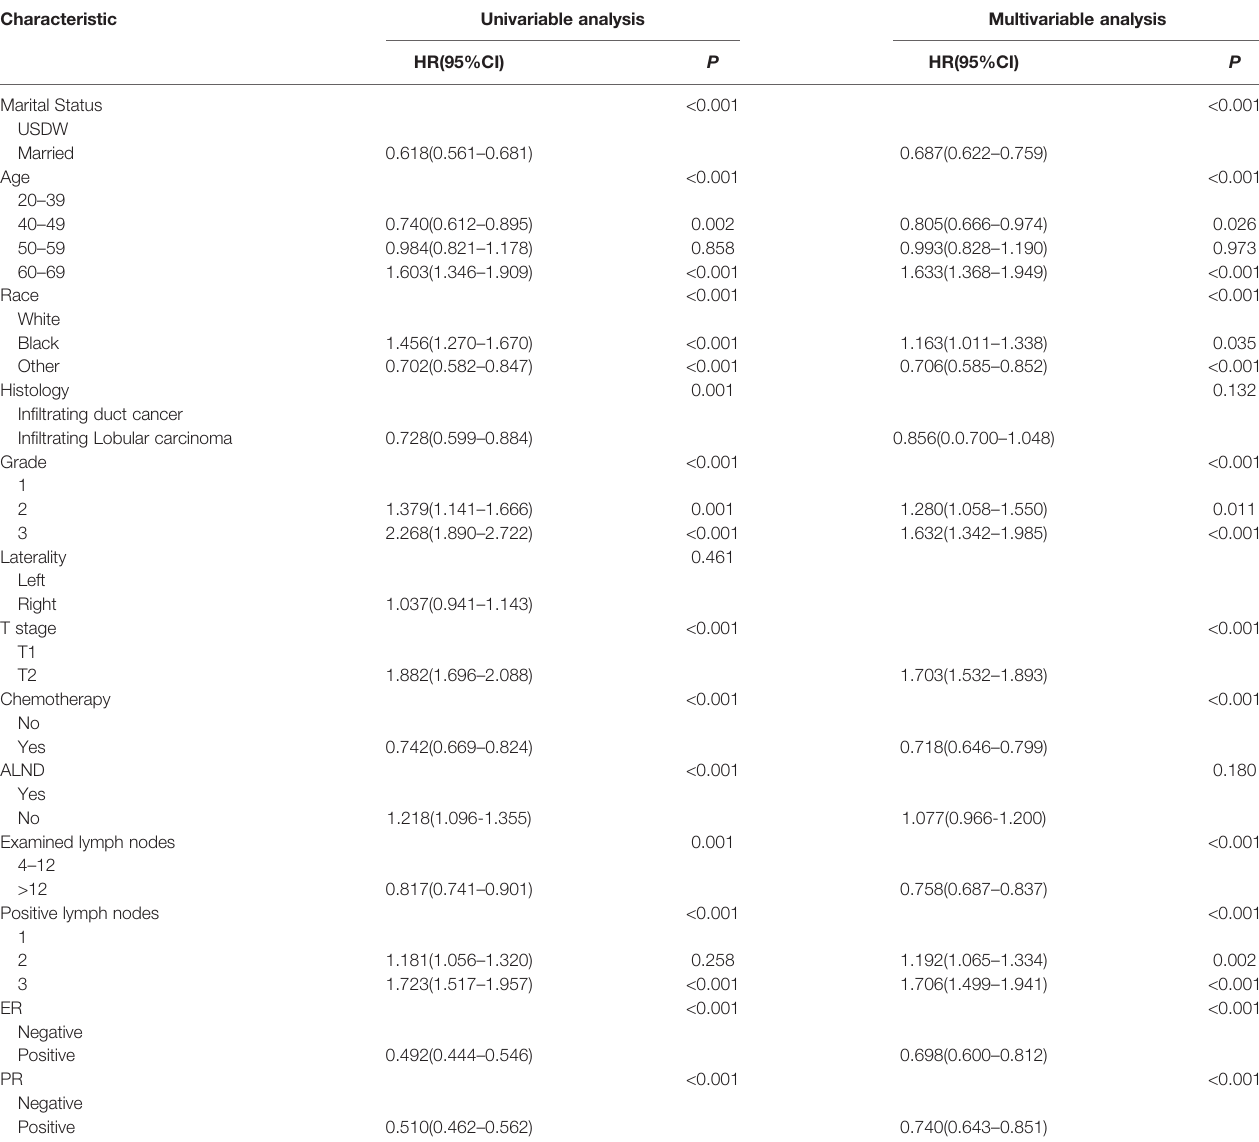
TABLE 2 | Univariable and multivariable Cox analysis for predicting overall survival in T1 – 2 breast cancer with 1 – 3 positive lymph nodes in the control cohort.